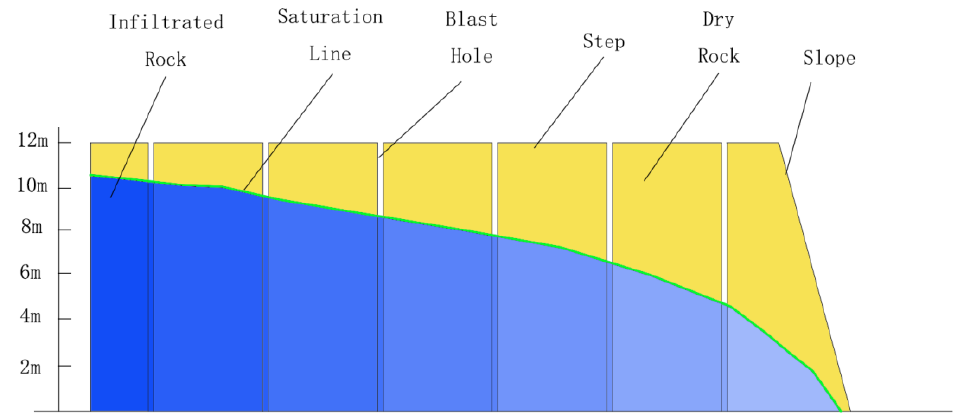
Figure 2. Step waterline